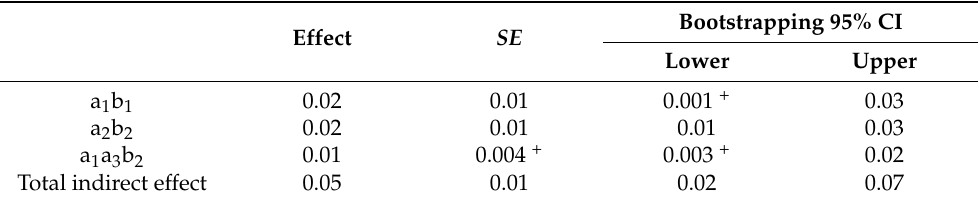
Table 4. Bootstrapping point estimates and 95%CIs for all indirect effects with maternal control as the independent